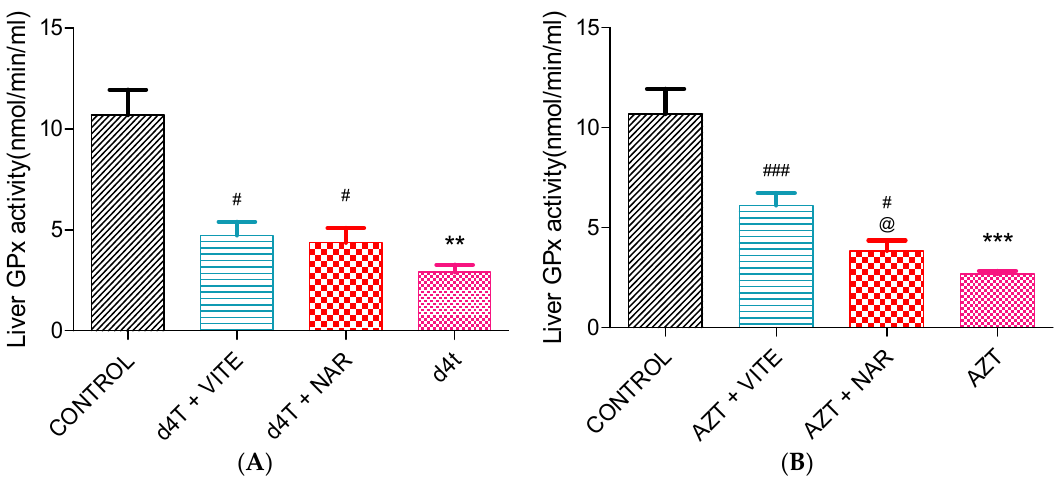
Figure 4. Liver glutathione peroxidase activity following 56 days of drug administration. ( A ) d4T ‐ (** p < 0.01 compared to control and # p < 0.05 compared to d4T) and ( B ) AZT ‐ (*** p < 0.001 compared to control; # p < 0.05 and ### p < 0.001 compared to AZT) treated animals. @ p < 0.05 compared to vitamin E among AZT ‐ treated rats.